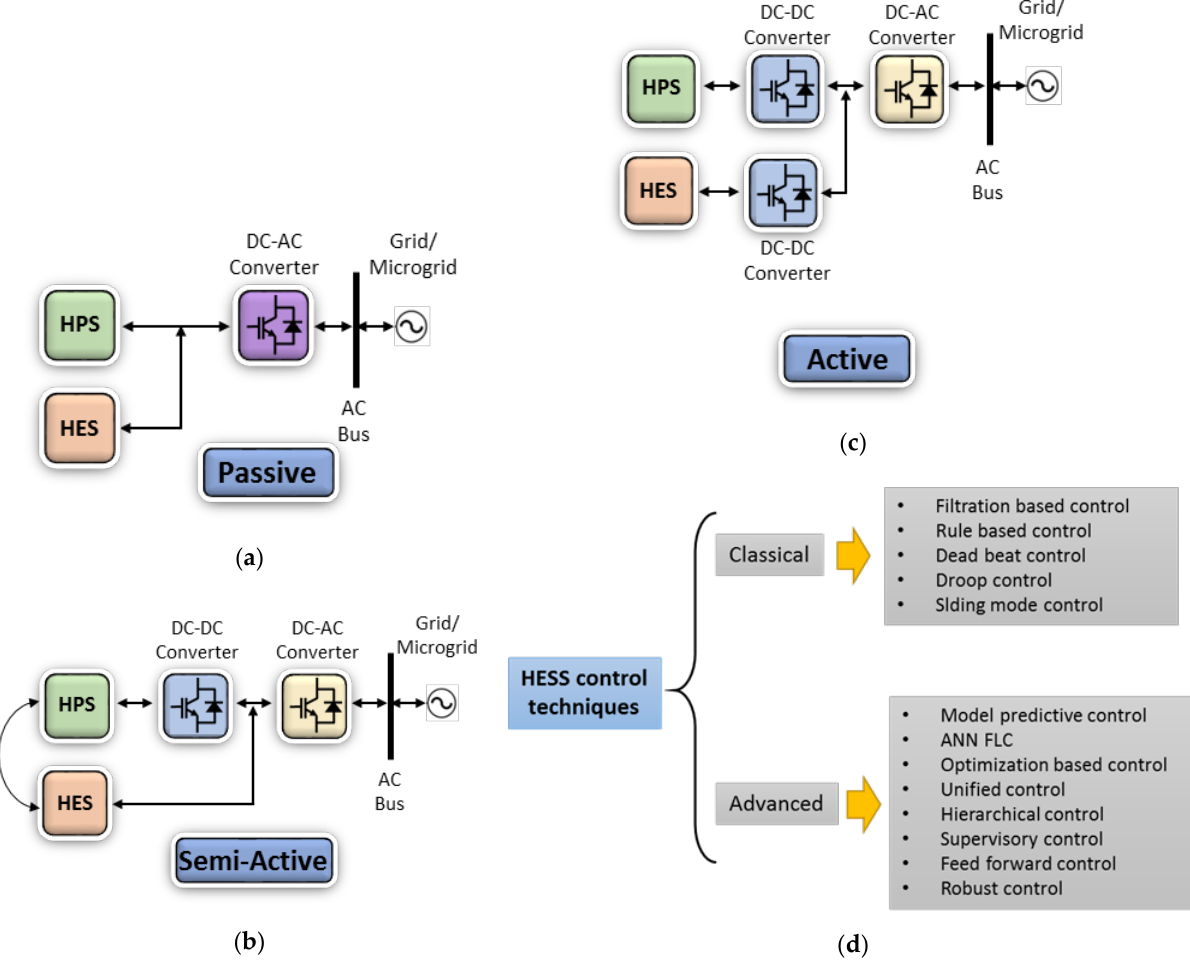
Figure 17. Main interconnection topologies for a HESS, formed by a high power storage (HPS) and a high energy storage (HES): ( a ) passive, ( b ) semi-active and ( c ) active adapted from [71]; ( d ) Classification of HESS control techniques adapted from [71].